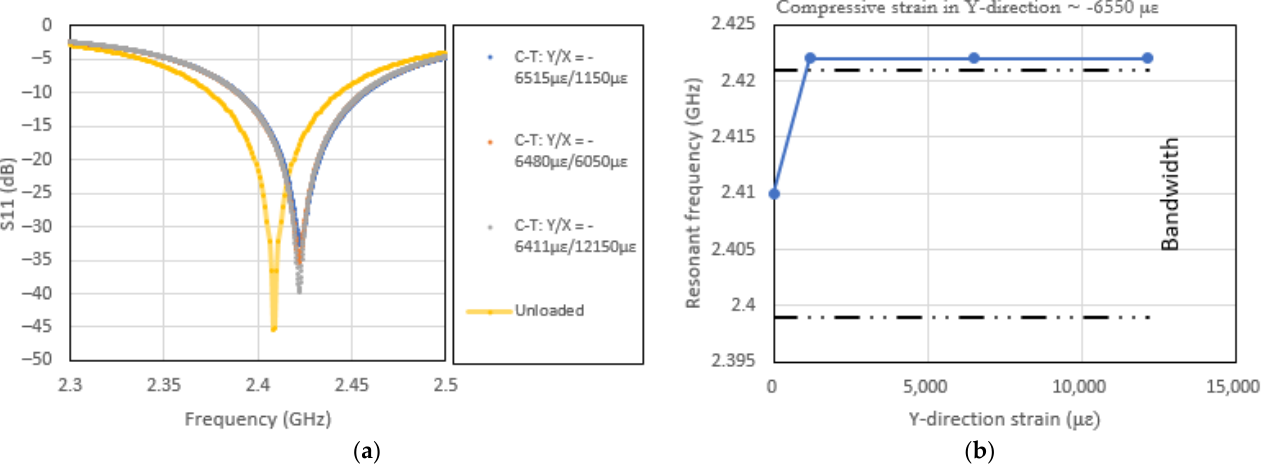
Figure 13. ( a ) Effects of bi-axial loading (compression–tension) on patch antenna’s S11 (Loading Case 2) and ( b ) resonant frequency excursion with respect to the CLAS bandwidth under bi-axial loading (compression–tension).